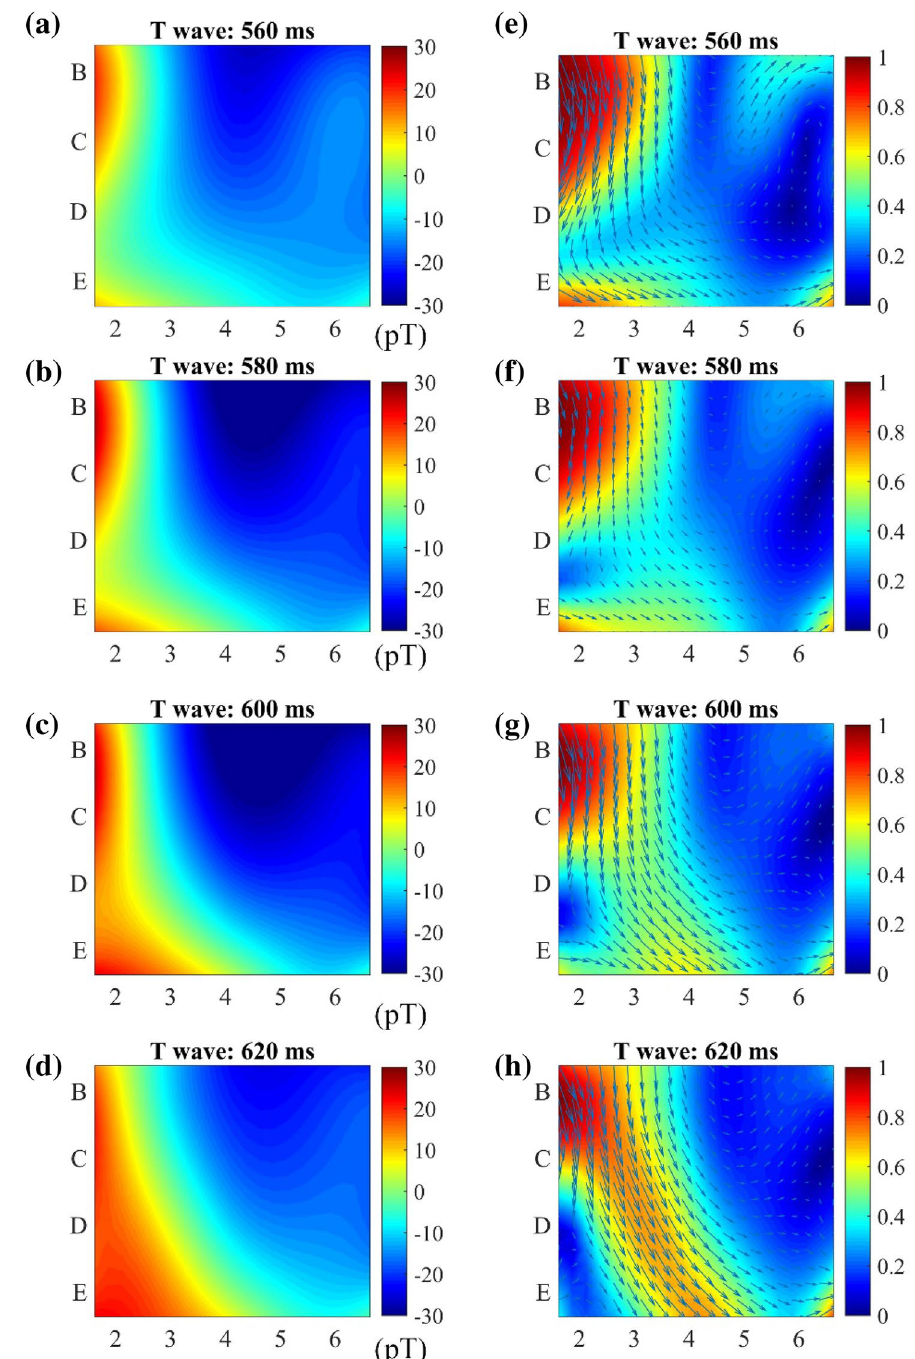
Figure 9. ( a – d ) MFMs and ( e – h ) corresponding PCD maps of a healthy subject during the T wave. The top to bottom panels represent the MFM and PCD maps constructed at different instants, 560 ms, 580 ms, 600 ms and 620 ms, of the cardiac cycle during the T-wave. ( e – h ) PCD map. The length and direction of the arrows indicate the magnitude and direction of the vector. In the MFM and PCD maps, both the Y-axis and X-axis scales represent sensor positions. The color of the MFM represents the magnetic field strength, and the color on the PCD maps represents the normalized current